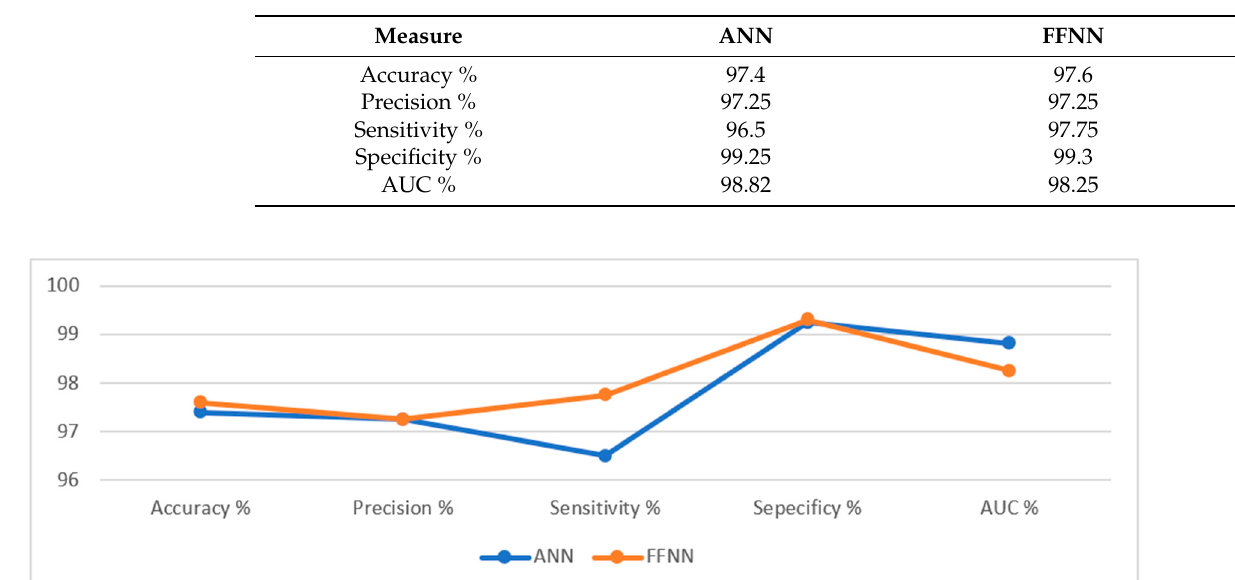
Figure 17. Display of the performance of the ANN and FFNN algorithms for diagnosing a low GI dataset.